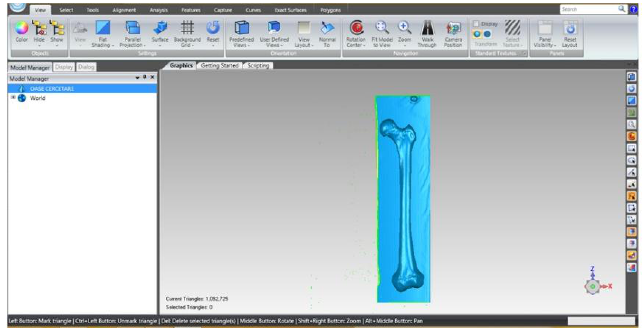
Figure 28. Primary geometry of the femur in Geomagic.